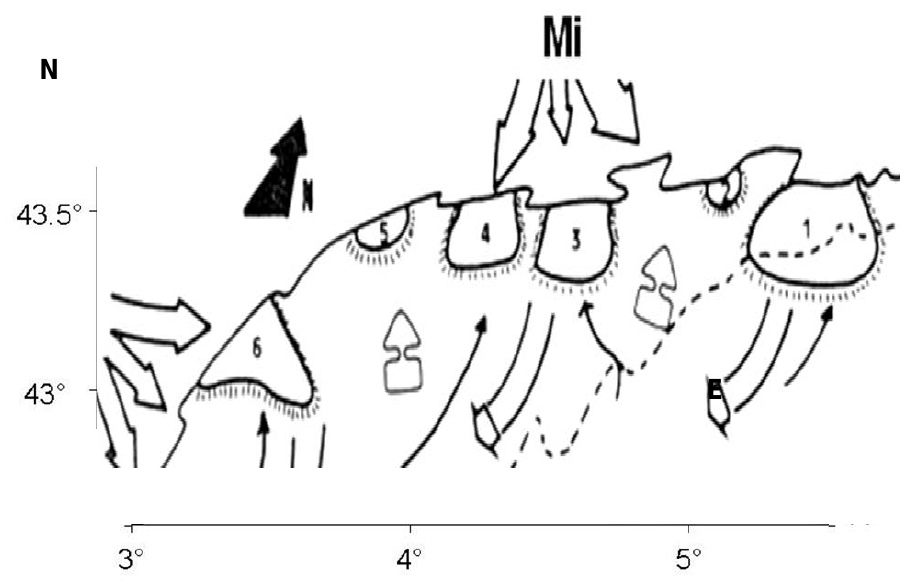
Figure 8. Schematic representation of Mistral- (Mi) and Tramontane- (Tr) induced phenomena in the GoL. 1-6 are upwelling zones. From Figure 2 of